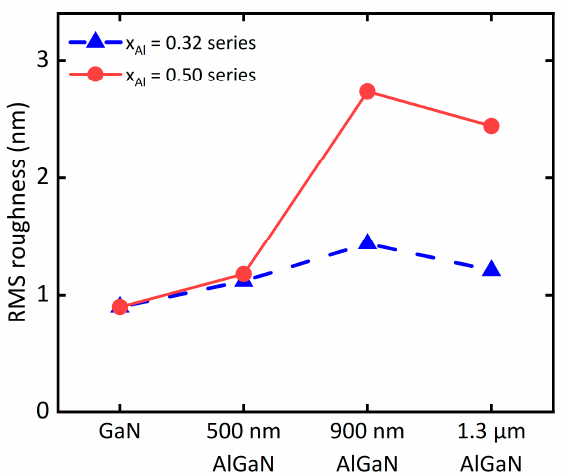
Figure 5. Graph showing the RMS surface roughness for the pseudo-substrate as well as after each AlGaN growth for both x Al = 0.32 and 0.50 samples. For the x Al = 0.32 sample, the roughness remained generally flat, however, it increases after first regrowth for the x Al = 0.50 sample. For the sample with x Al = 0.50, the (002) ω -FWHM amounted to 385 arc seconds,